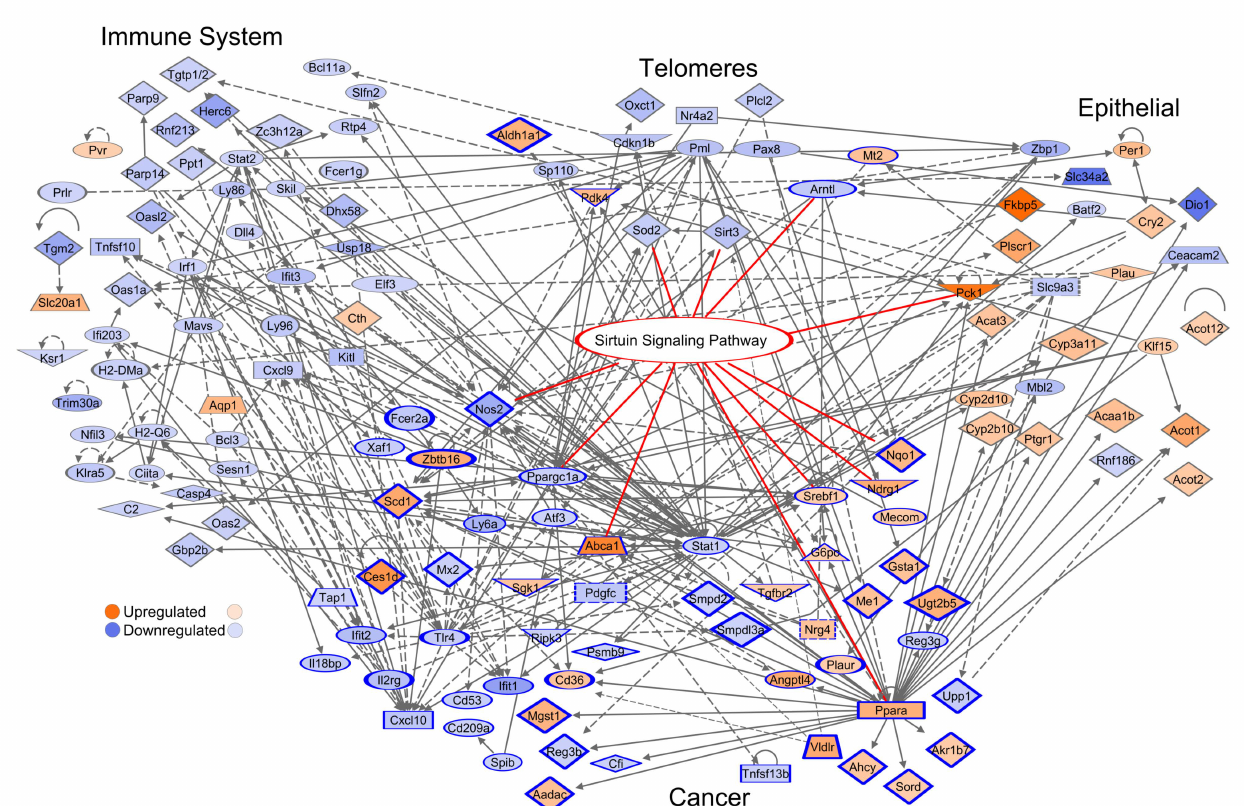
Figure 6. Cross-talk networks with Sirtuin Signaling Pathway. Cancer-related proteins have a dark blue shape outline. Sirtuin Signaling Pathway proteins have red edges. All DEGs encoding these proteins have adjusted p -value < 0.05 at |FC| > 1.5, except the telomere subset with |FC| > 1.2. Top hubs include Stat1 (44 downstream targets, 25 upstream targets), Ppara (42 downstream, 7 upstream), Tlr4 (25 downstream, 4 upstream), Ppargc1a (19 downstream, 11 upstream), Nos2 (14 downstream, 20 upstream), Pml (10 downstream, 4 upstream), and Cxcl10 (1 downstream, 17 upstream). These hubs account for 34.7% (243/700) of the edge